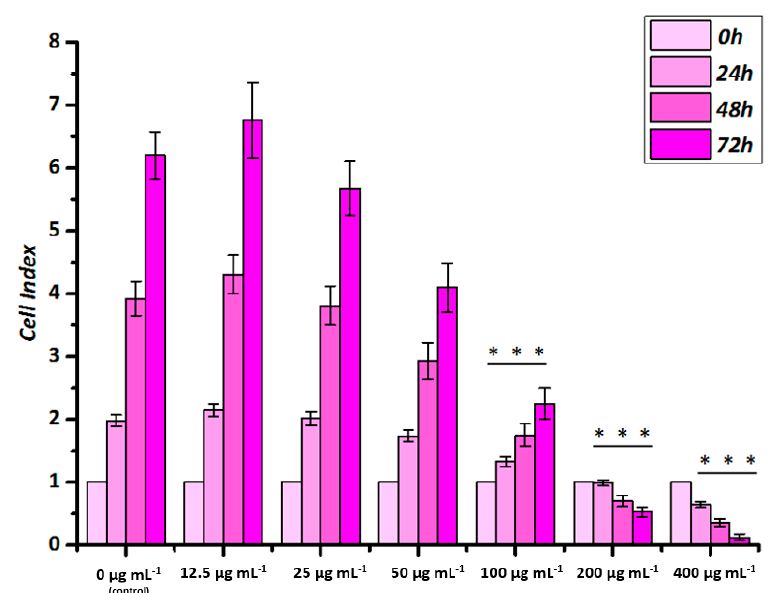
Figure 3. Biological effects of polyR-Fe 3 O 4 particles on endothelial cells grown in static conditions analyzed by real-time cell analysis. HUVECs were seeded 24 h before nanoparticle application. After the